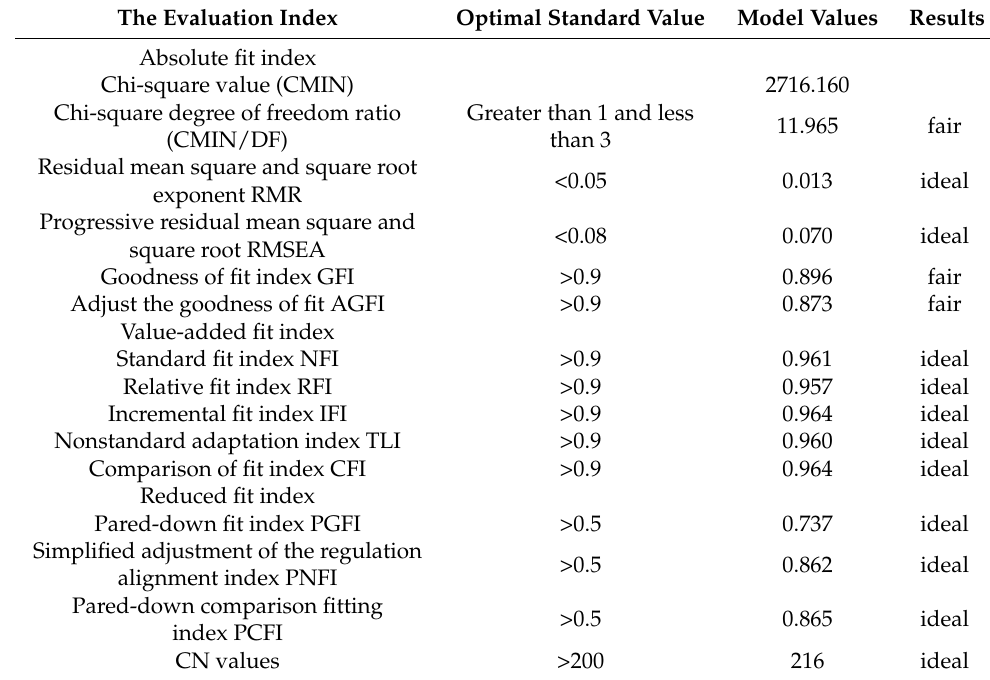
Table 5. Summary of the fit indices.